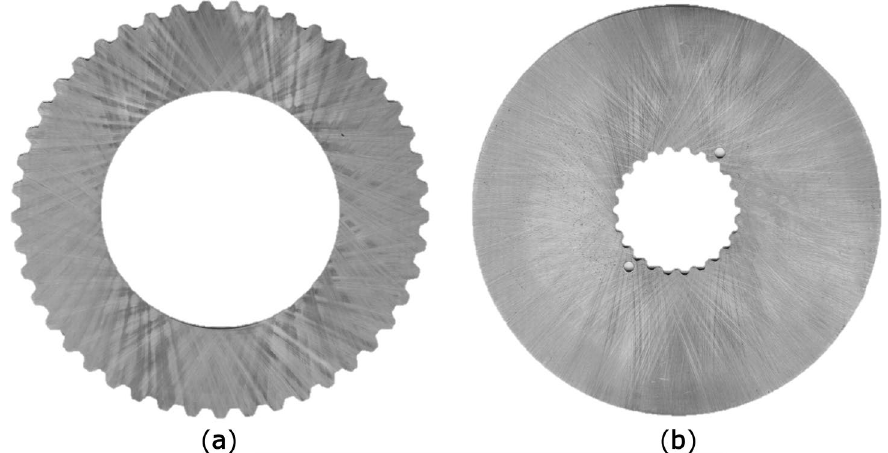
Figure 5. Clutch discs: ( a ) separator disc, ( b ) friction